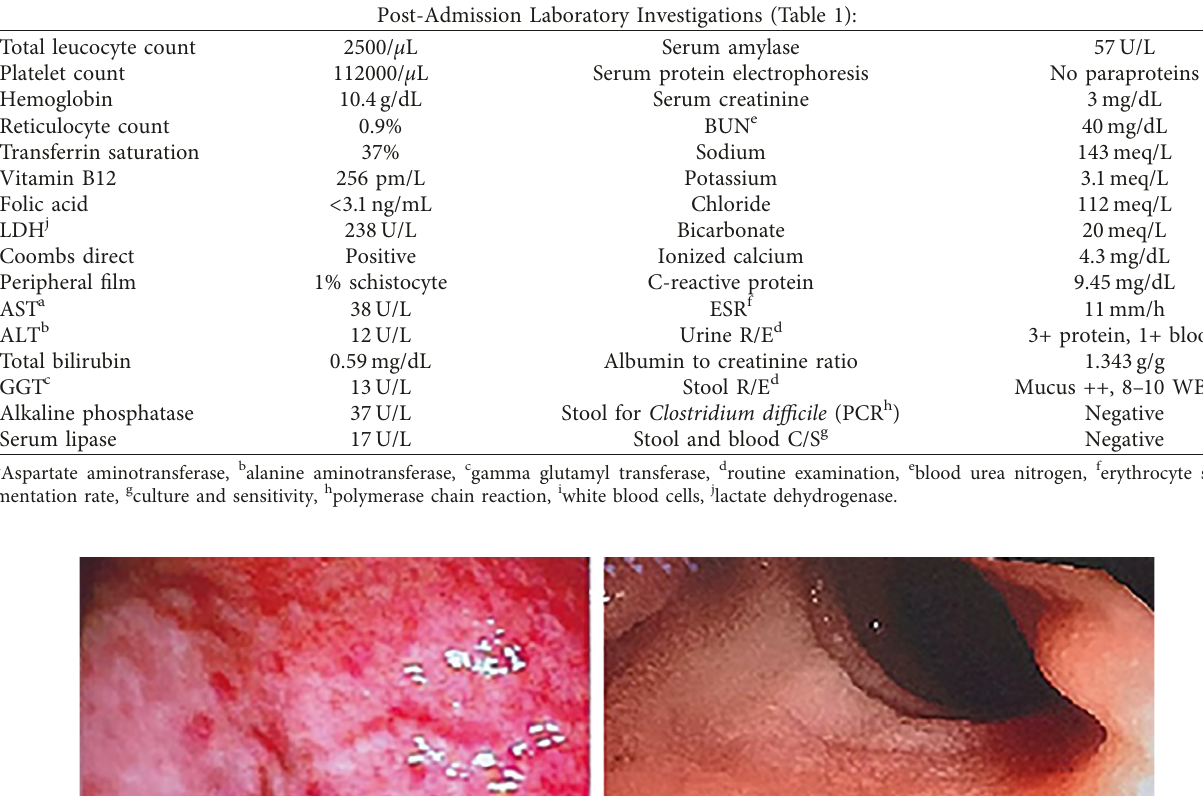
Table 1: Postadmission laboratory investigations. Post-Admission Laboratory Investigations (Table 1):